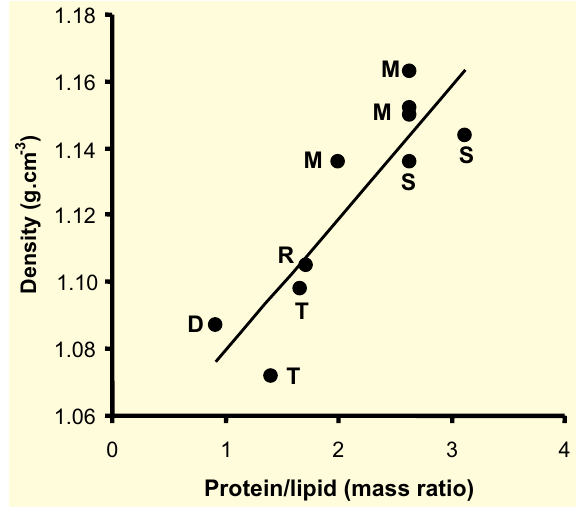
Fig. 1 – Densities and protein-lipid mass ratios of purified midgut microvillar mem- branesfromdifferentinsects. DensitiesweretakenfromTableIandthecorresponding protein-lipidratiosfromthecitedliterature. Thethreeheaviestmembraneswerefrom M. domestica posterior midgut and their densities were averaged before displaying in Table I. D, Dysdercus peruvianus ; M, Musca domestica , R, Rhynchosciara amer- icana ; S, Spodoptera frugiperda ; T, Tenebrio molitor